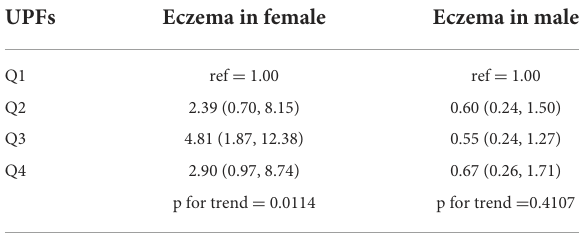
TABLE 4 The associations between UPFs and eczema by sex in children, NHANES